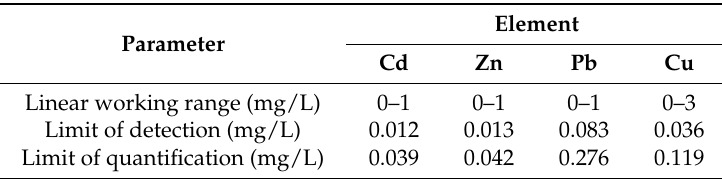
Table 5. Limit of detection (LOD) and limit of quantification (LOQ) of the flame atomic absorption spectroscopy method.